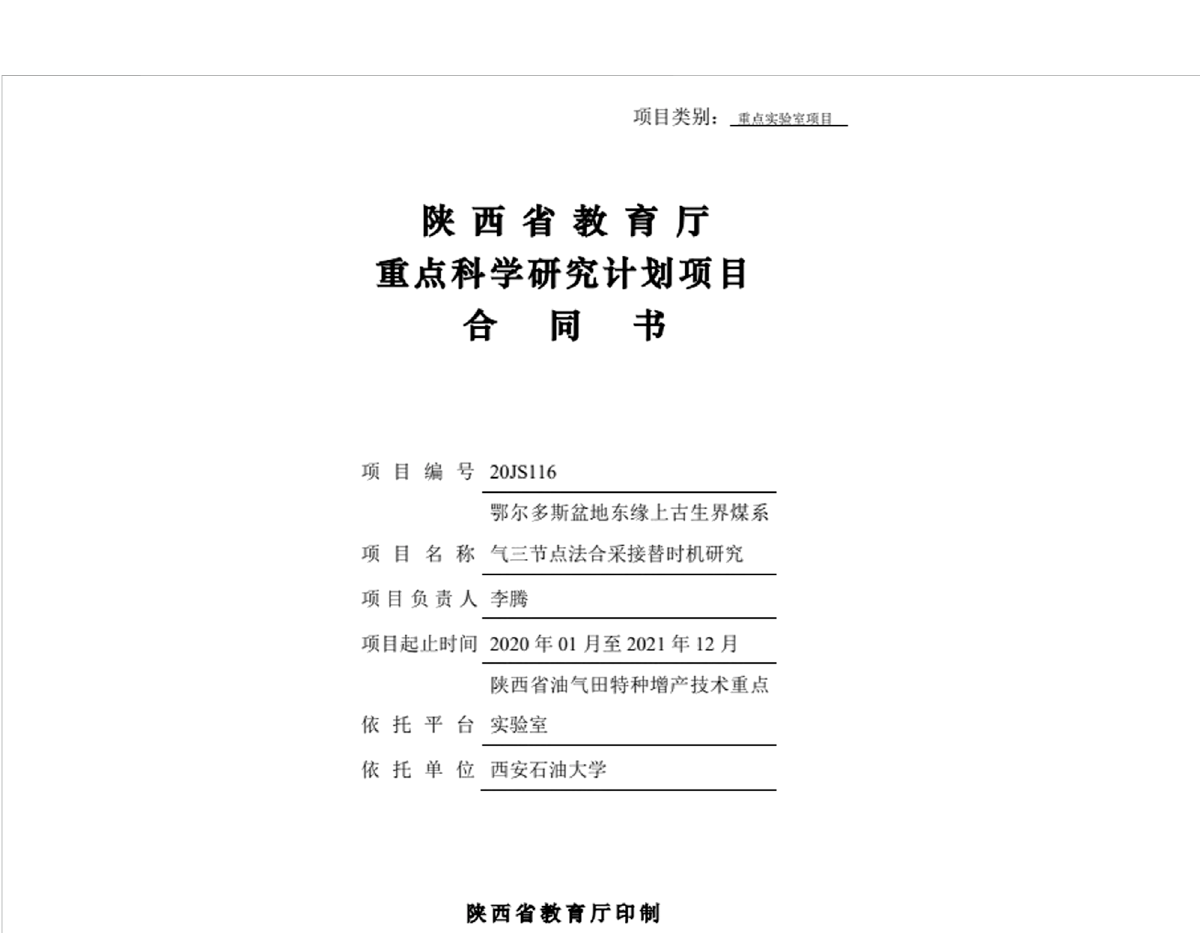
FIGURE 1 The SEM photos of the CTOS-7 and CTOS-19 samples. (Yellow zone is the colloidal intergranular pore, green zone is the intergranular solution